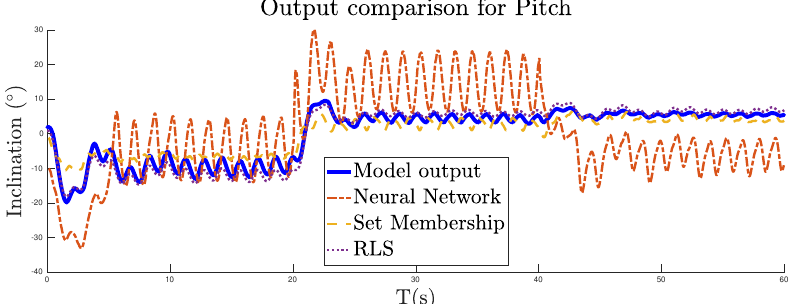
Figure 22. Prediction configuration results for pitch in Test